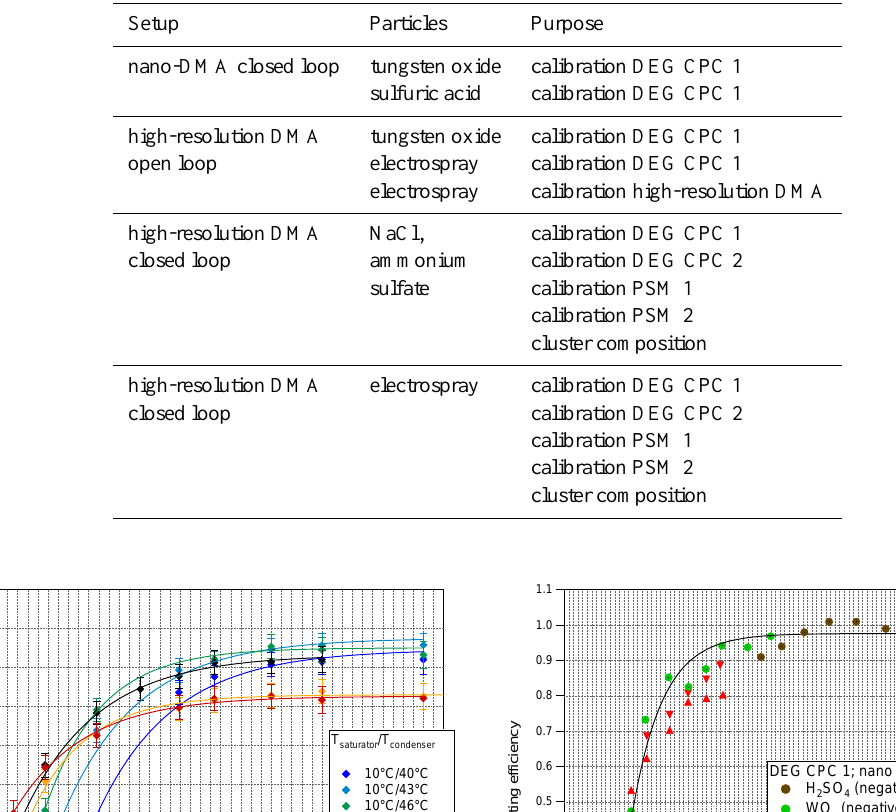
Table 1. Summary of DMAs, calibration setups and aerosol generators used.